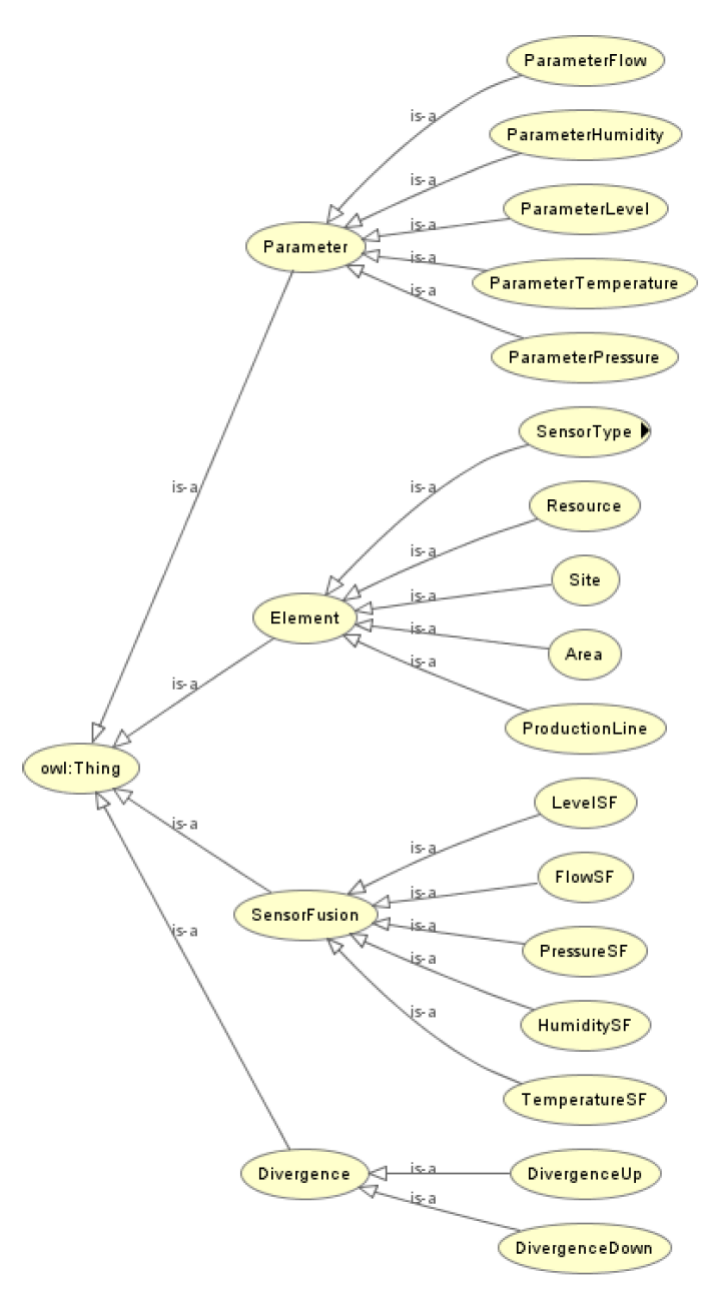
Figure 2. A partial description of the proposed